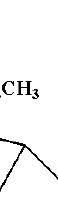
Figure 1. Chemical structure of borneol.